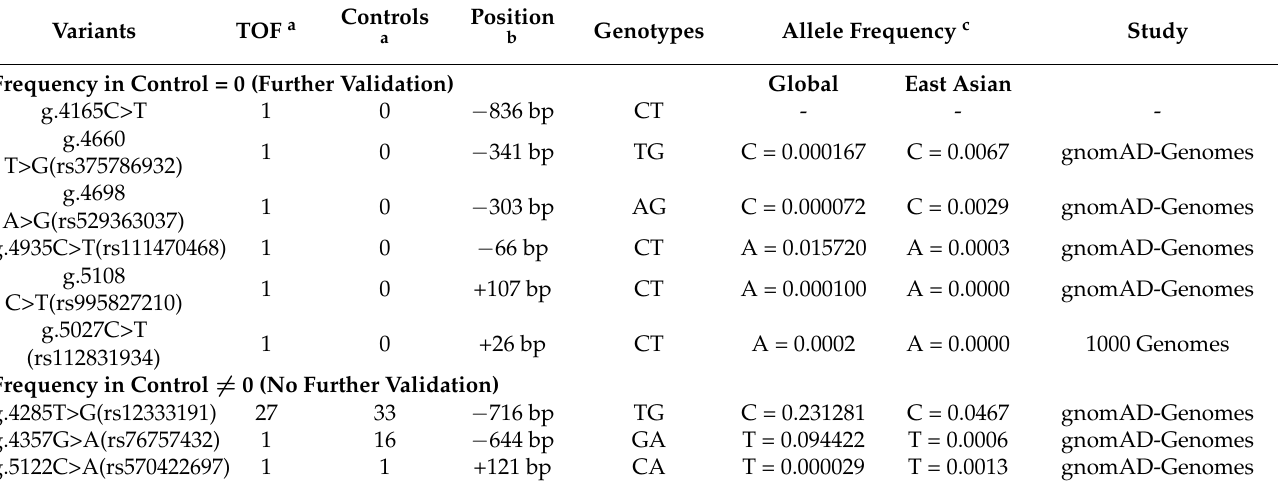
Table 2. Genetic variants of CITED2 gene promoter in TOF patients and